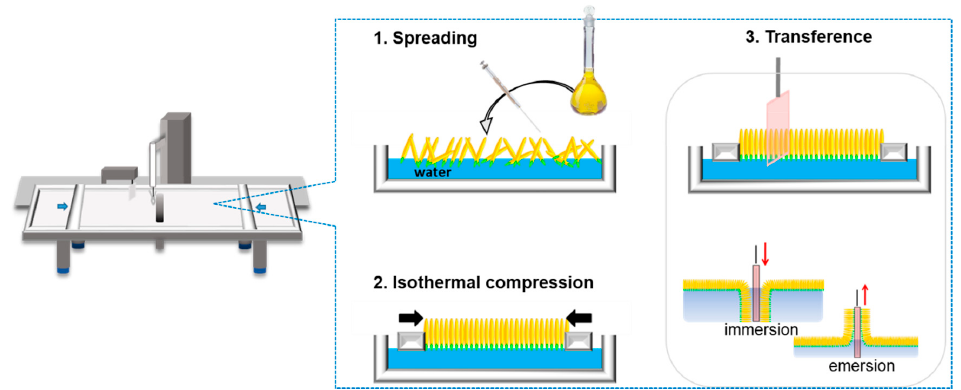
Figure 3. Scheme showing the main steps involved in the Langmuir–Blodgett monolayer (LBM) fabrication. First, an organic solution containing the molecule of interest is spread on the water surface. Second, the molecules are organized upon an isothermal compression resulting in a Langmuir film. Finally, the monolayer is transferred onto a solid support—forming the